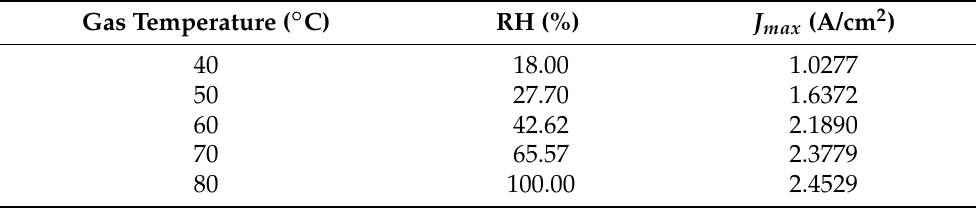
Table 2. RH and J max values for the different gases temperature tested in the experiments.